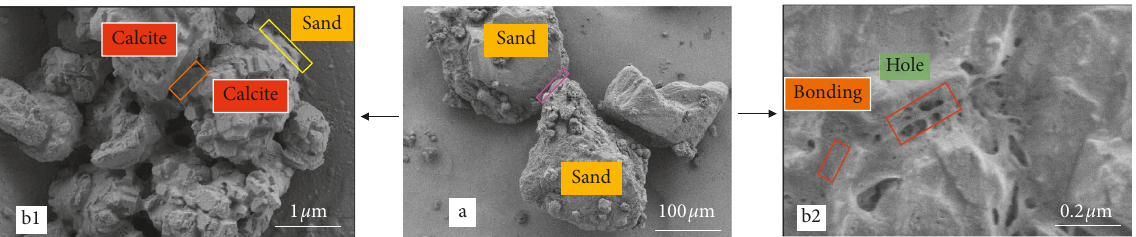
Figure 5: SEM micrographs and cementation formation in the physical